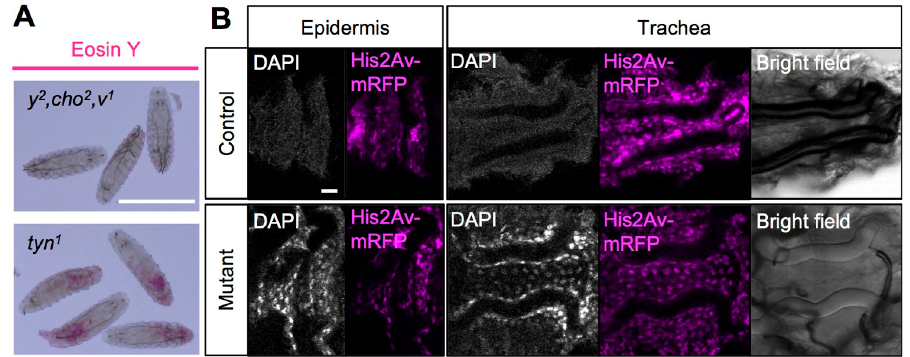
Fig 3. Leakage of molecules through the tyn mutant body surface. (A) Eosin Y penetrated the body of tyn 1 , y 2 , cho 2 , v 1 larvae but not of y 2 , cho 2 , v 1 . Scale bar: 500 μ m. (B) DAPI staining was observed in neither the epidermis nor trachea of the control larvae (+/+; Ubi-GAP-43GFP, His2AV-mRFP), while some of the epidermal and tracheal cells were strongly labeled with DAPI in the mutant larvae ( tyn 1 , y 2 , cho 2 , v/Y; Ubi-GAP-43GFP, His2AV-mRFP). His2AV- mRFP (magenta) was expressed to visualize nuclei in all the cells. Bright-field images show that the trachea was gas- filled in the control but not in the mutant. Scale bar: 10 μ